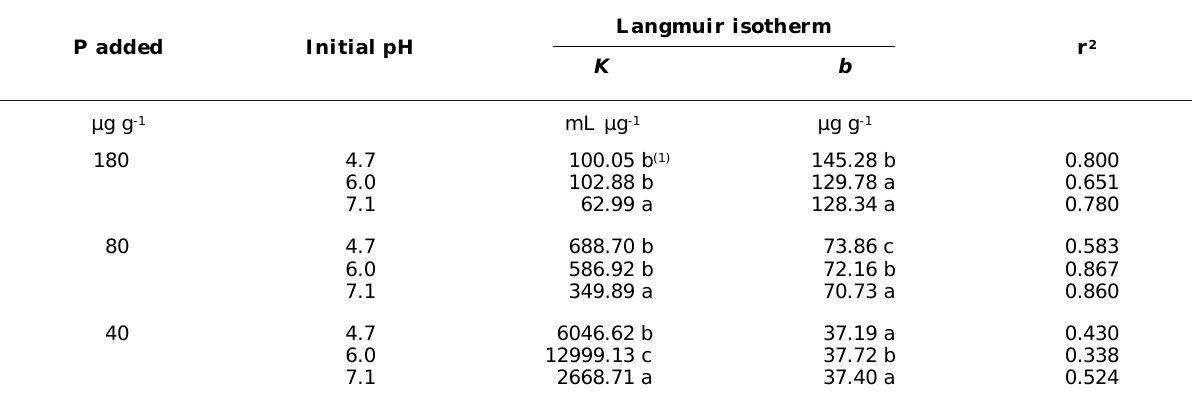
Table 4. Langmuir parameters for P desorption isotherms at three different soil pH levels with three different initial P-addition levels